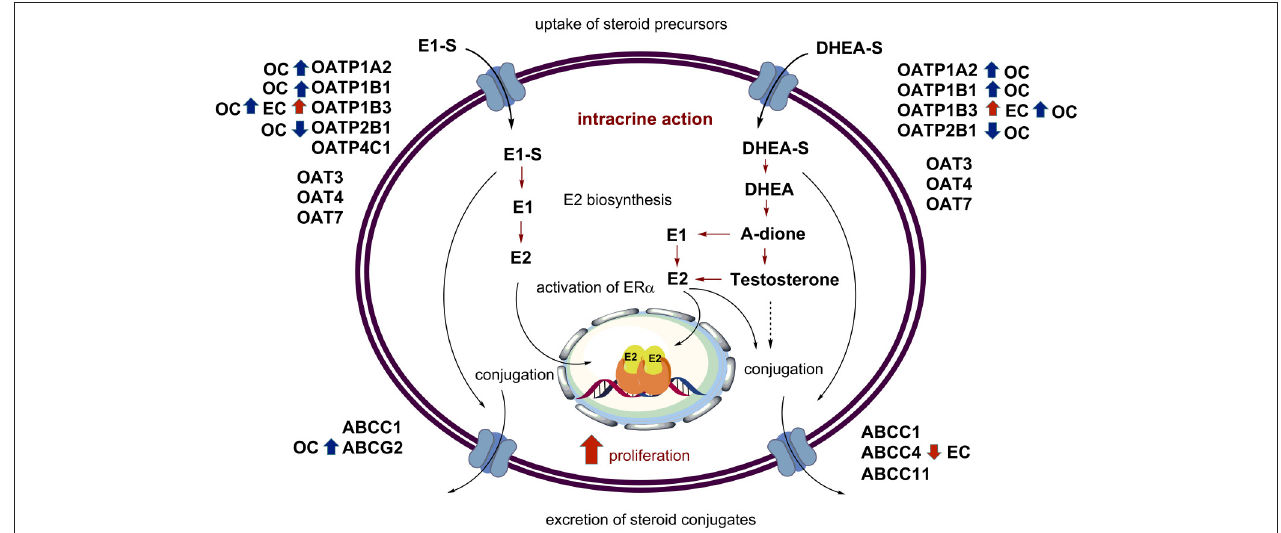
FIGURE 2 | Uptake, intracrine action, and excretion of steroid hormones. The major players in intracrine estrogen action are depicted, with the additional data on the levels of OATP, OAT, and ABC-transporters in endometrial (red arrows) and ovarian cancers (blue